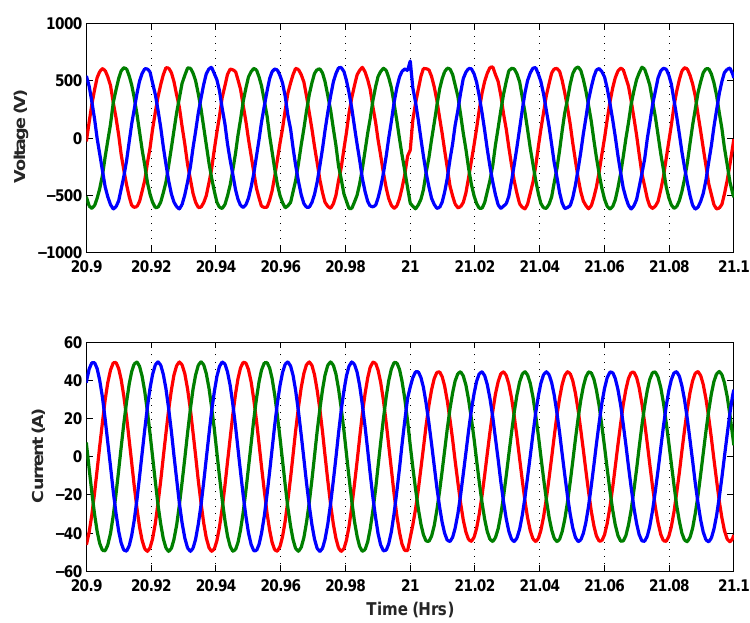
Figure 25. Domestic load changes from 20 kW to 18 kW.